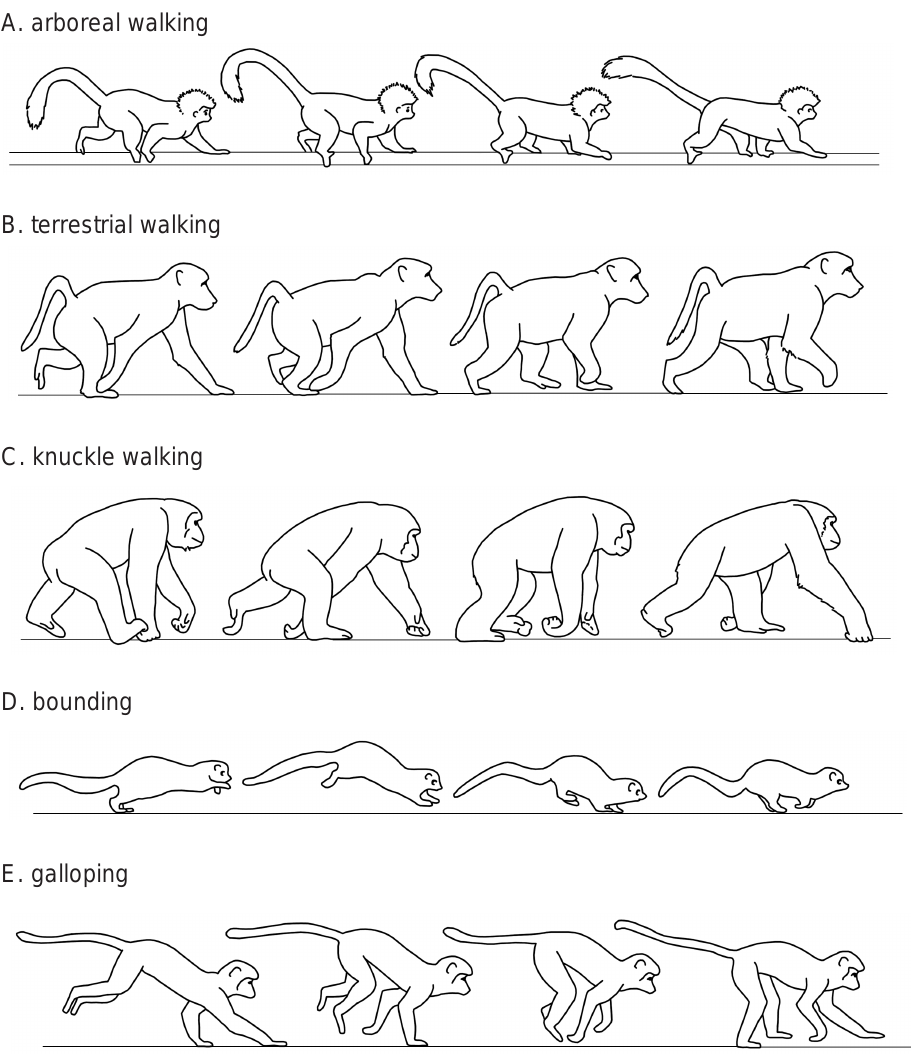
Figure 1. Quadrupedalism in primates. Symmetrical (A, B, C) and asymmetrical (D, E) gaits. (A) arboreal walking (cotton-top tamarin, Saguinus oedipus ). (B) terrestrial walking (chacma baboon, Papio ursinus , drawn from Muybridge (1957)). (C) knuckle walking (chim- panzee, Pan troglodytes , drawn after Larson (1998)). (D) bounding (fat-tailed dwarf lemur, Cheirogaleus medius , drawn from Preuschoft et al. (1995)). (E) galloping (vervet monkey, Chlorocebus aethiops, drawn after Larson and Stern